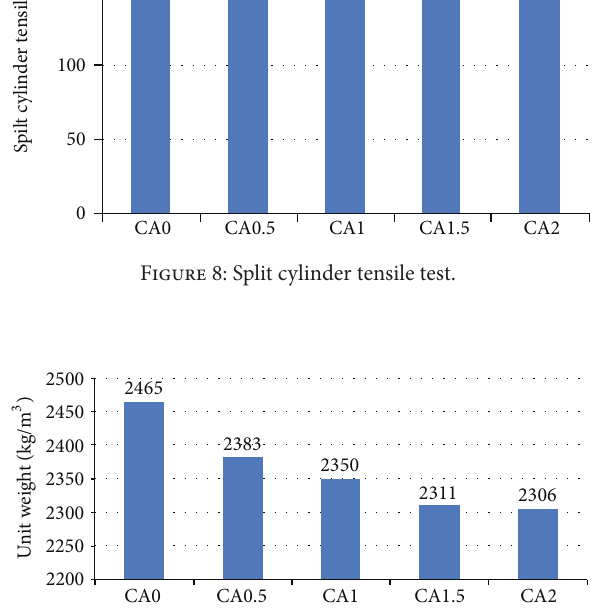
Figure 9: Comparison of average unit weight in specimens.